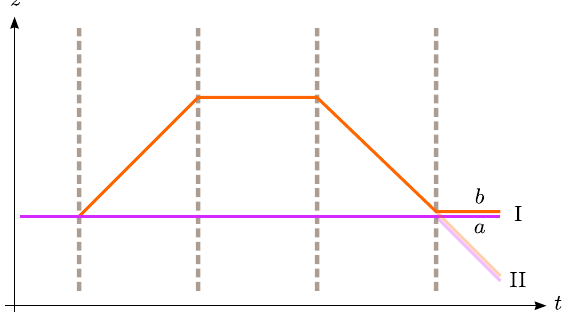
FIG. 4. Central trajectories for a Ramsey-Bord´e [27] interfer- ometer in a uniform gravitational field as seen in the freely falling frame. In this frame, the spacetime trajectories are straight lines, and the propagation phases are manifestly independent of the gravitational acceleration g . Laser pulses are depicted by grey dashed lines.